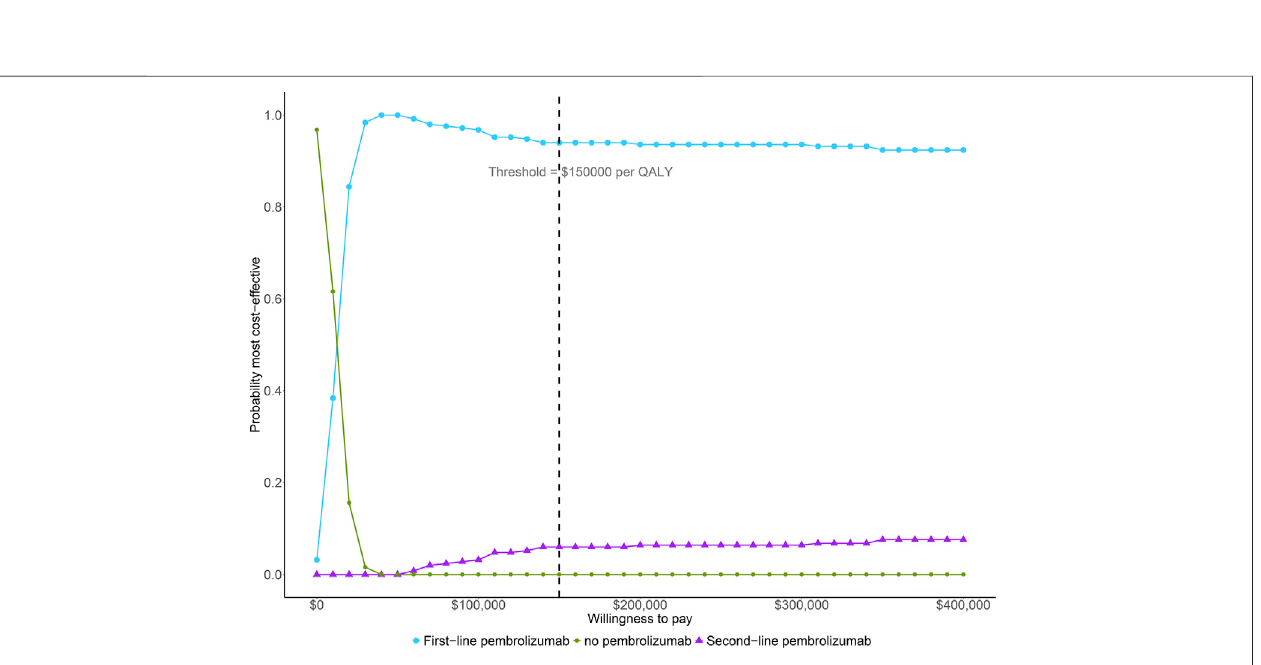
Frontiers in Pharmacology |